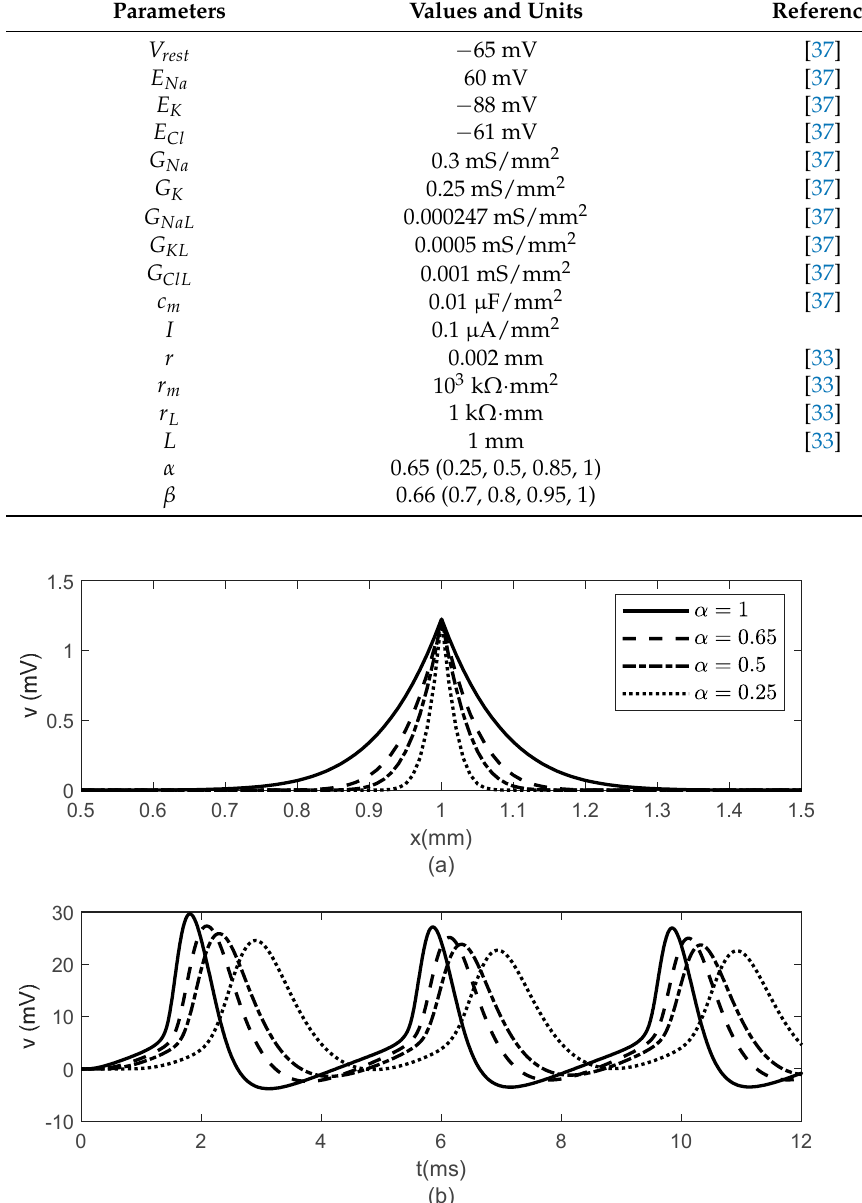
Figure 3. ( a ) Spatial variations of v ( x , t ) at t = 0.1 ms, and ( b ) temporal variations of v ( x , t ) at x = 700 µ m for various values of α . Here, p = 1, q = 0, and β = 1.